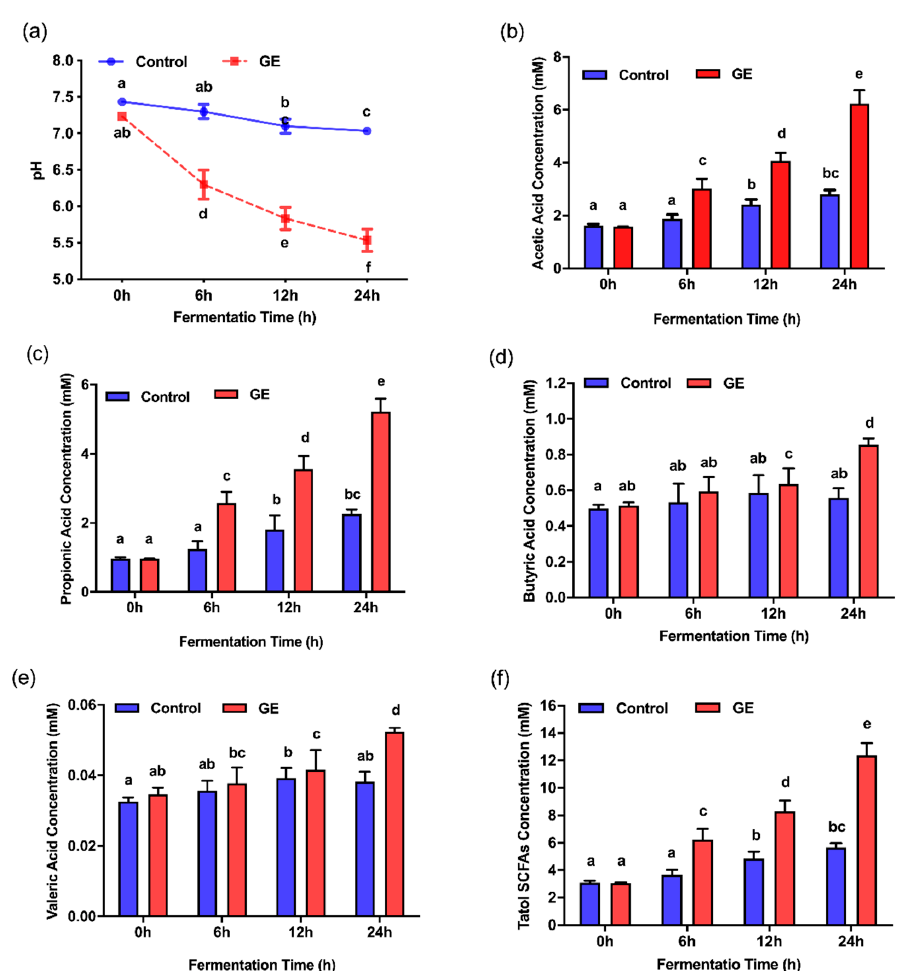
Figure 3. Concentrations of short-chain fatty acids (SCFAs) and pH values in predigested ginger extract